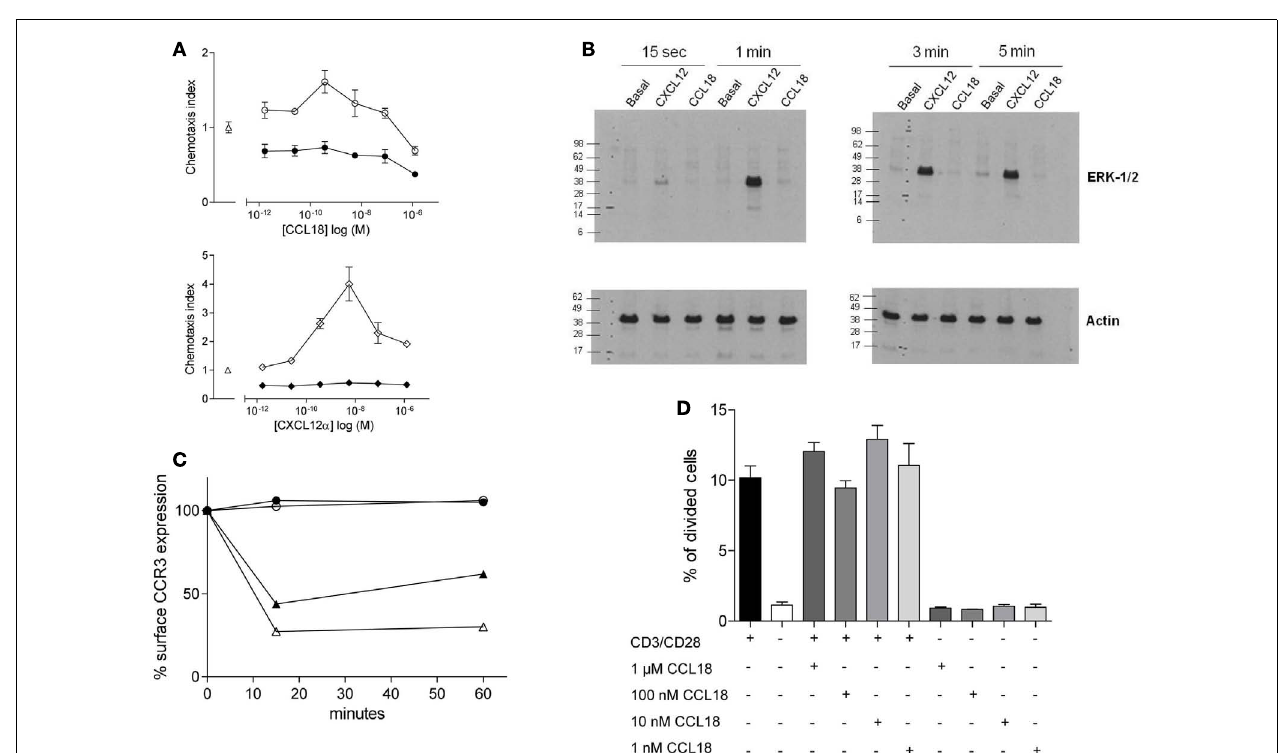
stimulated with 100nM CCL18 or CXCL12 α . Detection of actin was used as a loading control. (C) CCR3 cell surface expression after CCL18 stimulation of human eosinophils. Human eosinophils were stimulated with 12.5nM CCL18 ( ◦ ), CCL5 ( (cid:78) ), CCL11 ( ∆ ), or 125nM CCL18 ( • ) for 15 or 60min. Ligand-induced CCR3 internalization was measured by Flow cytometry. Surface expression of CCR3 was compared with CCR3 expression of unstimulated eosinophils. Results are expressed in % of CCR3 surface expression. (D) T lymphocyte proliferation analysis after CCL18 stimulation.T lymphocytes were stimulated or not with anti-CD3/CD28 antibodies in the presence or absence of an increasing concentration of CCL18 (1nM, 10nM, 100nM, or 1 µ M).The division of cells was measured by CFSE and flow cytometry. Data points are in triplicate. Data are expressed in % of divided cells ±